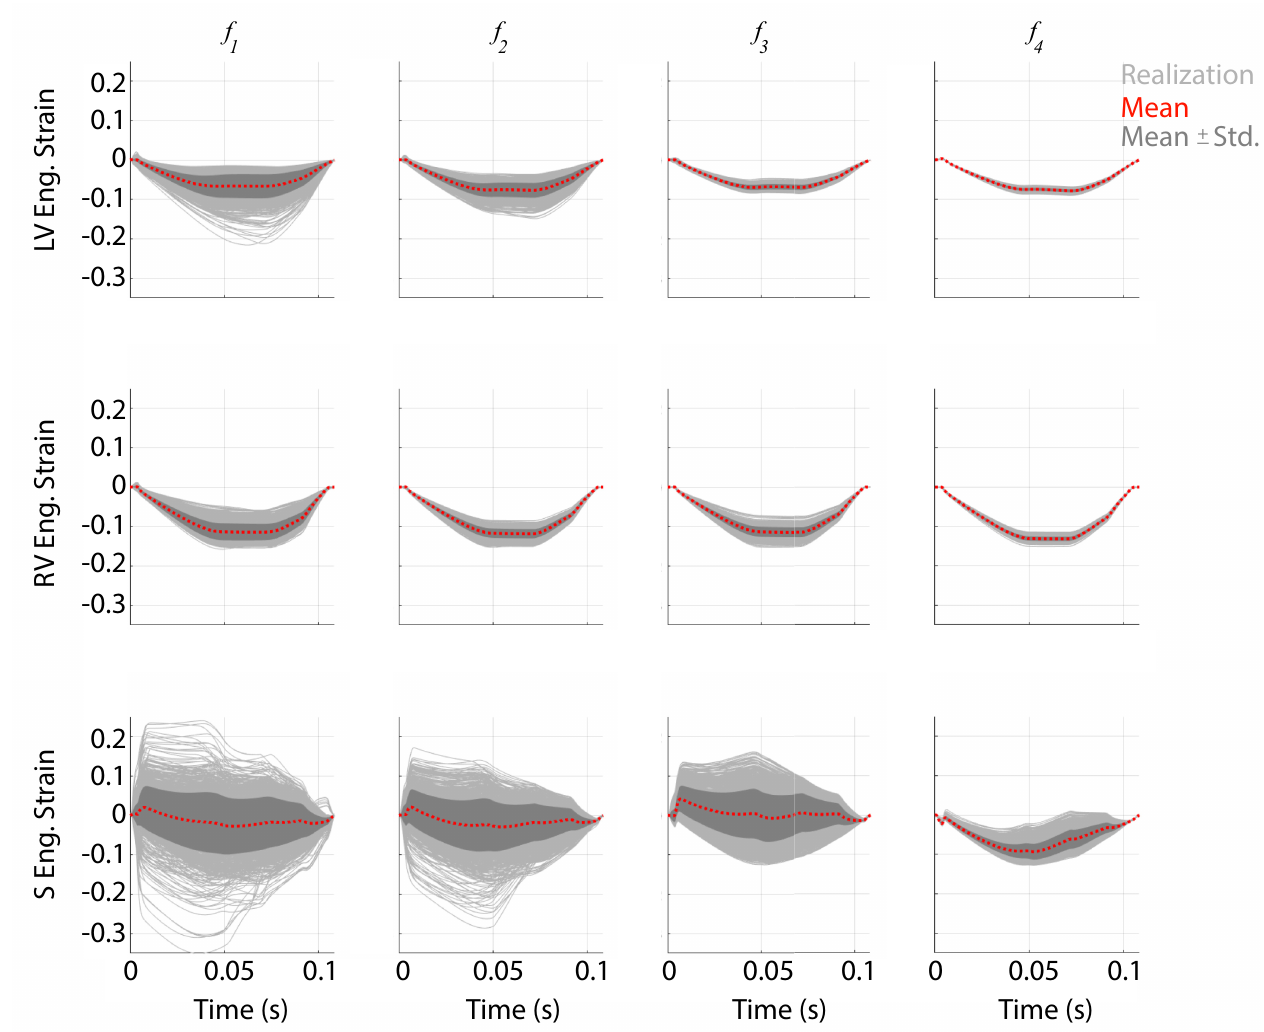
Fig 11. Forecast uncertainty in LV, RV, and S wall strain. Realizations in the LV, RV, and S engineering strain, along with the mean and ± standard derivation (Std), obtained from the posterior distributions. For designs only including RV dynamics ( f 1 and f 2 ), S engineering strain has a large uncertainty in the direction of strain (i.e., leftward or rightward). Designs including LV data ( f 3 and f 4 ) reduce the range of S strains, with the design f 4 ensuring that S strain is in the same direction as the LV. LV and RV strain have substantially less uncertainty than that of S, which shrinks with more informative